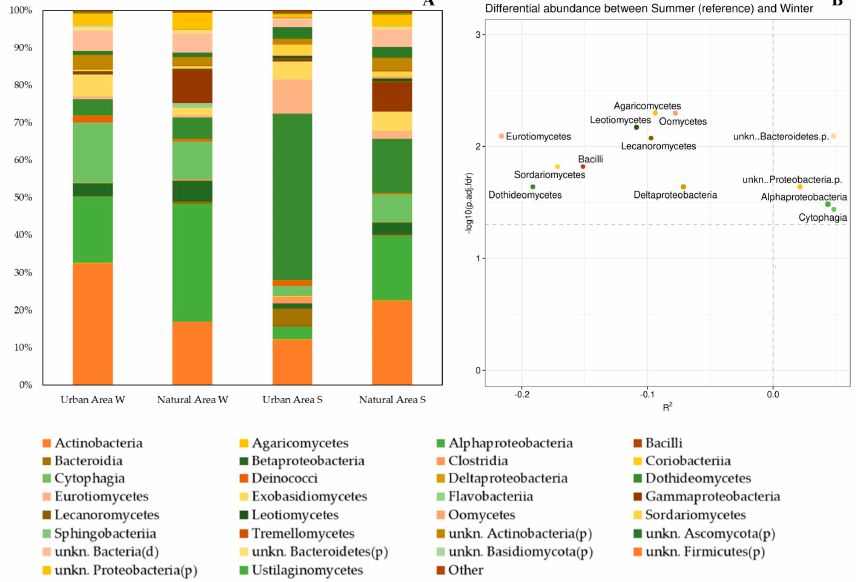
Figure 3. ( A ) Relative average abundance of phyllospheric bacterial and fungal taxa at Class level. ( B ) Differential Abundance Analysis (DAA) plot (based on ZicoSeq ( GUniFrac package). The plot shows the y -axis as the log10 (adjusted) p -value and the x -axis as the signed R 2 , which indicate the association direction with the covariate ( − and + with urban and natural areas, respectively). The names of differential taxa passing a specific significance cutoff (permutation-based FDR-adjusted p -Values = 0.1) are printed on the figure. ( A ) Only taxa with an average abundance ≥ 0.10% in at least one of the four groups (Urban Area W, Natural Area W, Urban Area S, Natural Area S) of samples are shown. Samples are grouped according to sampling season (W = winter or S = summer) and environmental features (Urban Area or Natural